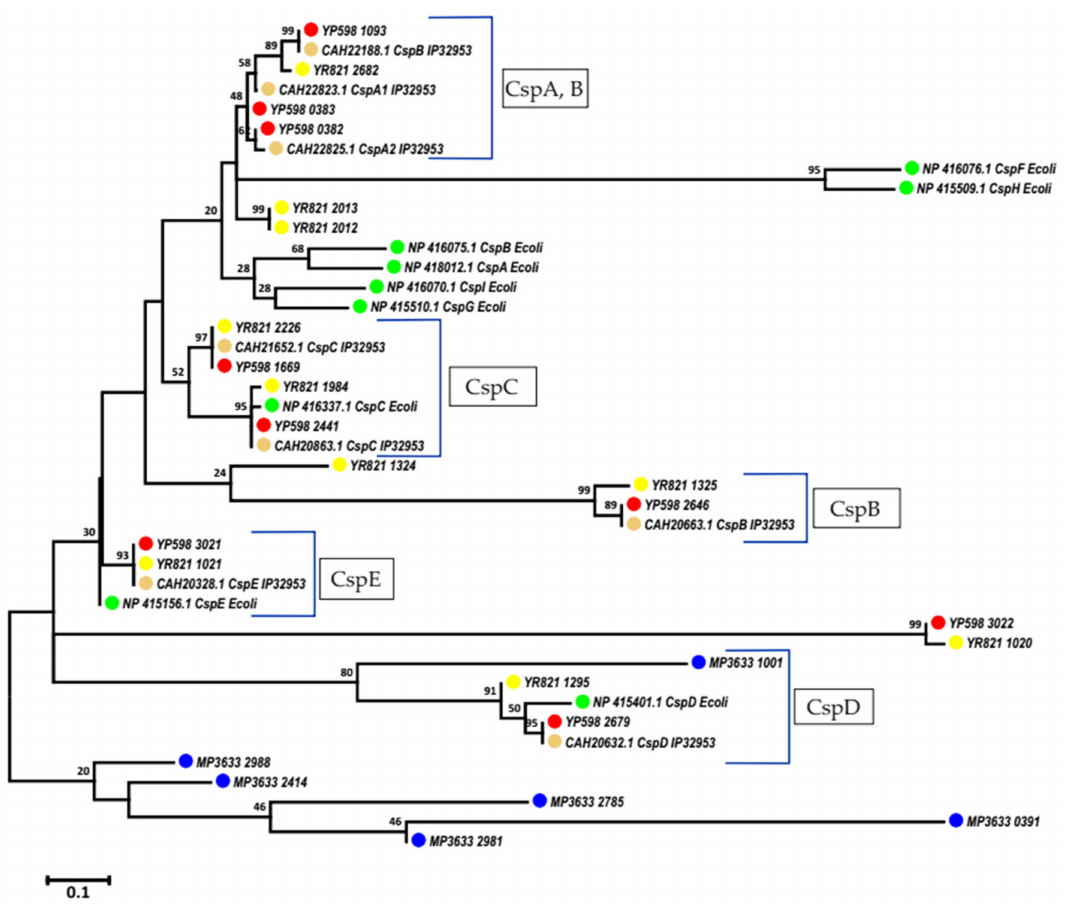
Figure 4. Phylogenetic tree of the cold shock proteins (Csps). Green mark— Escherichia coli K-12 W3110; orange— Y. pseudotuberculosis IP32953; blue— M. primoryensis KMM3633 T ; red— Y. pseudotuberculosis 598; yellow— Y. ruckeri